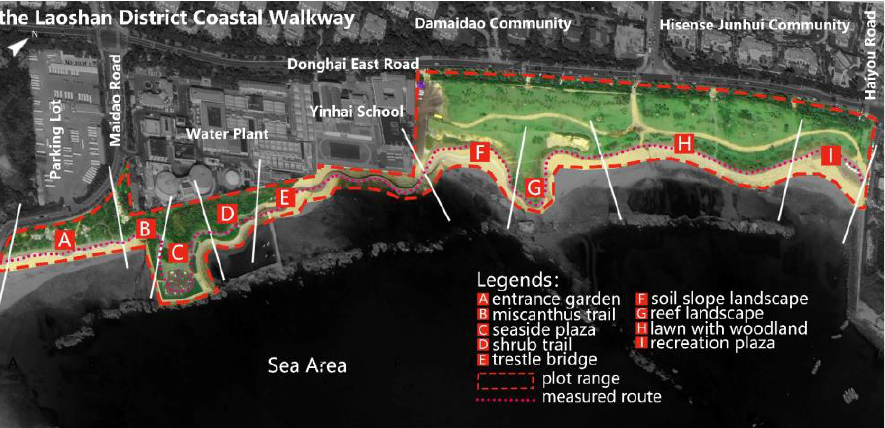
Figure 3. The plan of the section from Maidao Road to Haiyou Road of the Laoshan District Coastal Walkway.